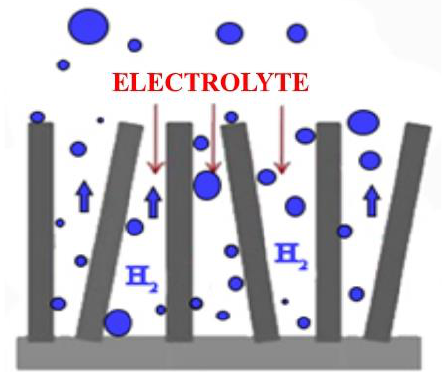
Figure 11. Schematic representation of screening effect of hydrogen bubbles.